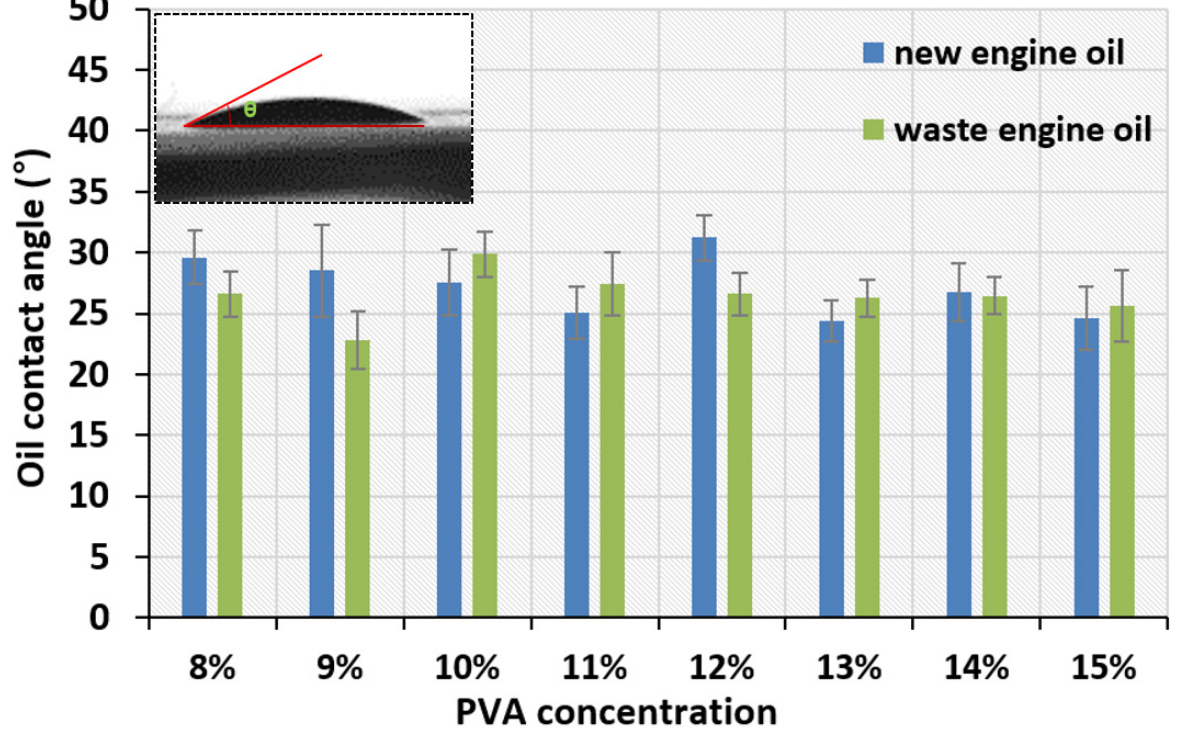
Figure 11. Oil contact angles for all tested PVA membranes.